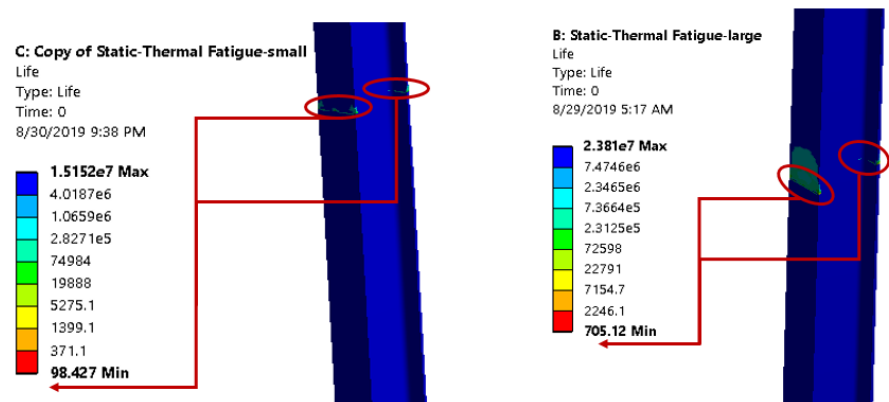
Figure 14. Fatigue life contour of the steel pile of an integrated concrete bridge due to temperature variations (the right side image is related to the large variations and the left side image is related to the small variations).